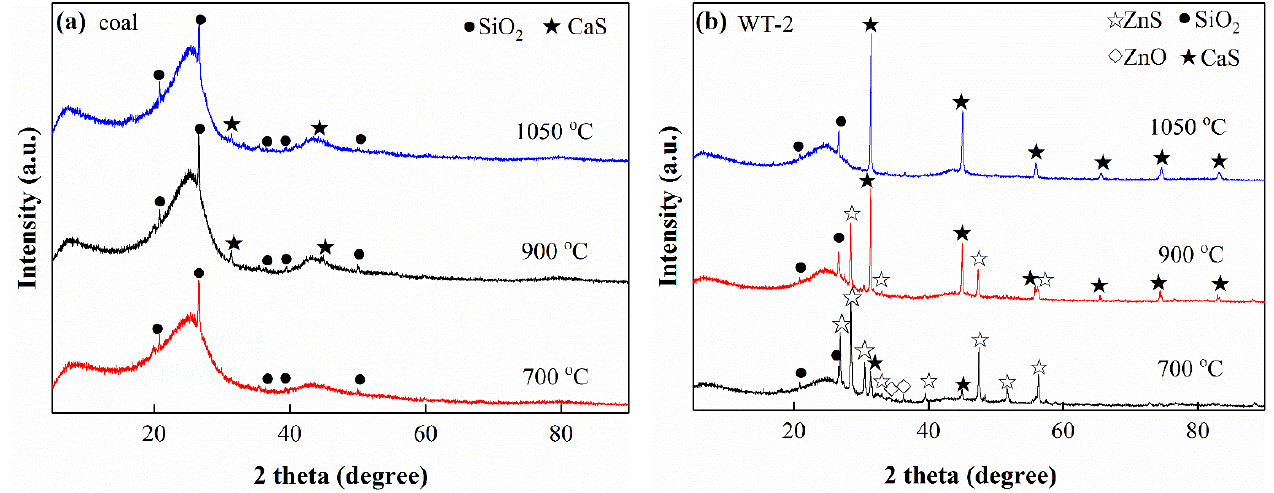
Figure 4. XRD patterns of cokes obtained by the separate pyrolysis of coal ( a ) and WT-2 ( b ) at dif- ferent temperatures.